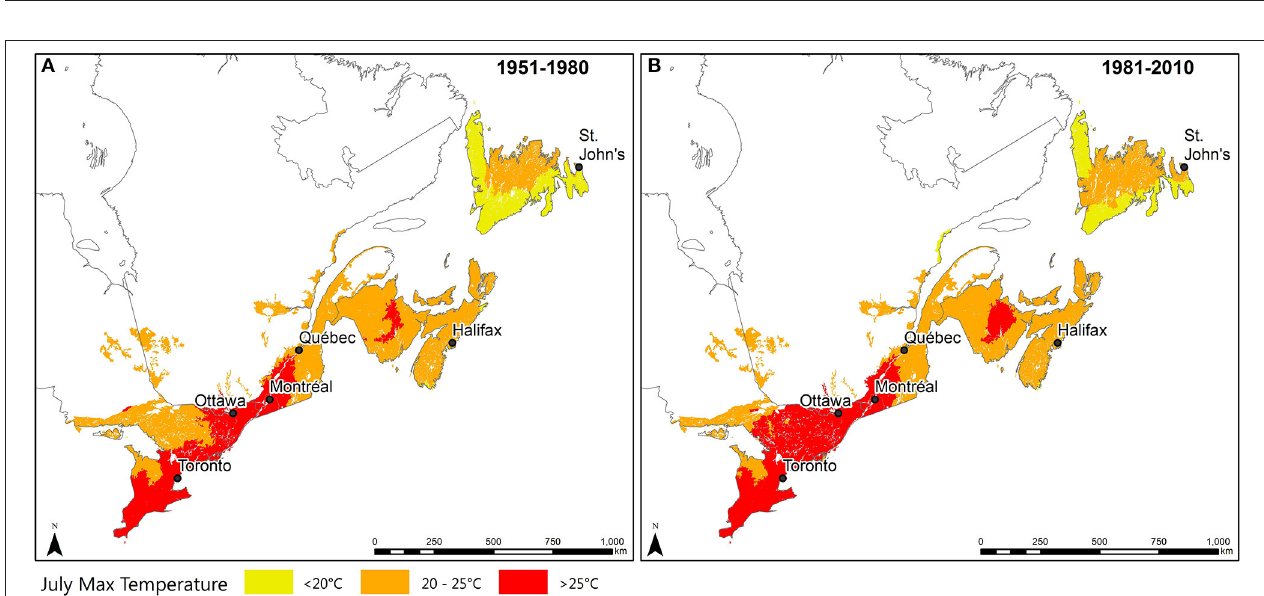
FIGURE 3 | Allocation of gridded climate data to detailed soil survey (DSS) map polygons (adapted from Gasser et al., 2016, reproduced with the permission of the copyright holder, NRC Research Press).